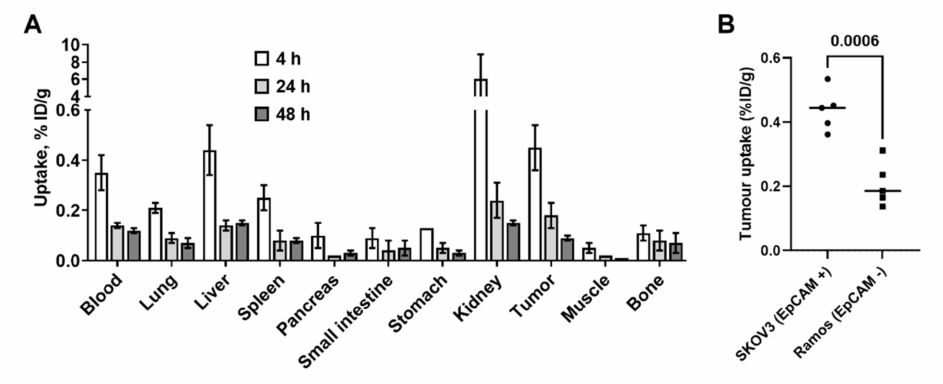
Figure 6. Biodistribution of [ 125 I]I-PIB-Ec1-LoPE in female BALB/c nu/nu mice. ( A ) Biodistribution of [125 I]I-PIB-Ec1-LoPE in mice bearing SKOV3 xenografts at 4, 24, and 48 h post-injection (pi). The uptake values are presented as an average from three to five animals ± SD. ( B ) Comparison ( t -test) of [125 I]I-PIB-Ec1-LoPE uptake in EpCAM-positive SKOV3 xenografts and EpCAM-negative Ramos xenografts 4 h pi. Difference between uptake in other organs in mice bearing SKOV3 (•) and Ramos (cid:4) ( ) xenografts was not significant ( p > 0.05, t -test).